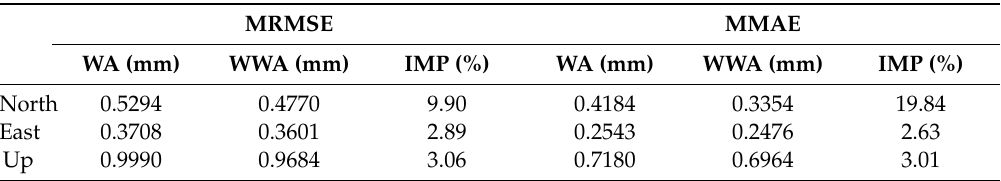
Table 2. Mean root mean square error (RMSE) and mean absolute error (MAE) of 500 simulations and improvement of WWA relative to